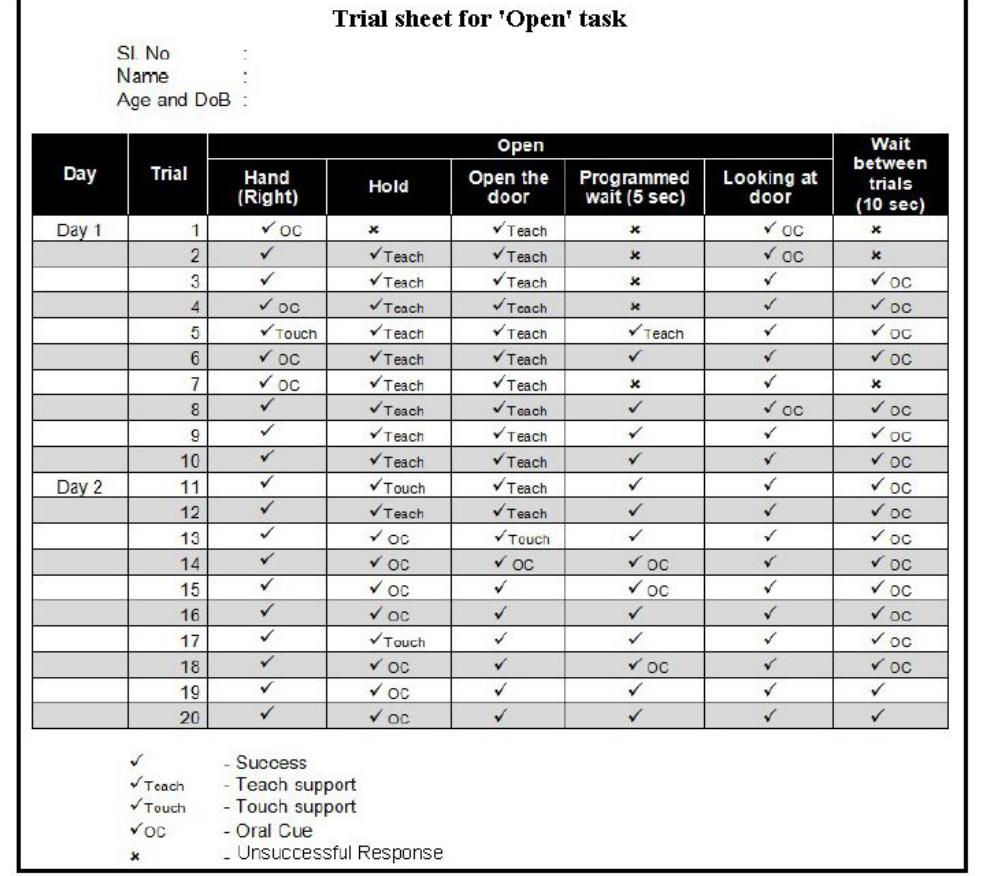
Figure 3: A typical trial